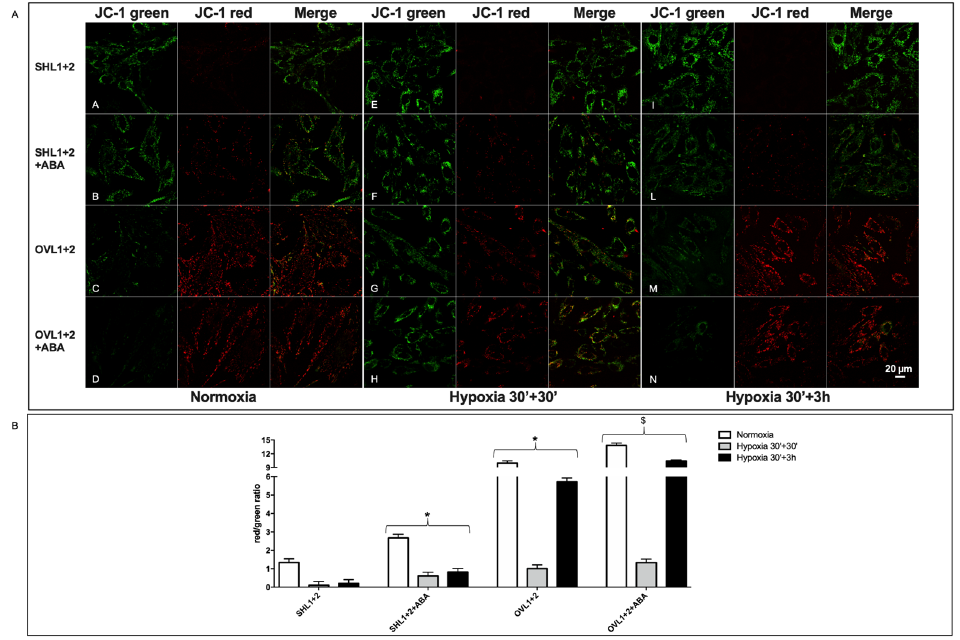
Figure 5. LANCL1/2-overexpressing H9c2 respond to ABA with an increase of the mitochondrial proton gradient after hypoxia/reoxygenation. H9c2 cells overexpressing LANCL1 and LANCL2 (OVL1+2), or double-silenced for the expression of both proteins (SHL1+2), loaded with the ∆Ψ - sensitive fluorescent dye JC-1, were cultured without or with 100 nM ABA under normoxia or subjected to 30 min of nitrogen flux followed by 30 min or 3 h reoxygenation at 37 ◦ C. ( A ) Repre- sentative confocal microscopy images of the cells exposed to the three different culture conditions, normoxia, hypoxia/reoxygenation (30 min + 30 min) and (30 min + 3 h). Rows A and B, double- silenced cells under normoxia, without (A) or with ABA (B); rows E and F, double-silenced cells after hypoxia/reoxygenation (30 min + 30 min), without (E) or with ABA (F); rows I and L, double- silenced cells after hypoxia/reoxygenation (30 min + 3 h), without (I) or with ABA (L). Rows C and D, LANCL1/2-overexpressing cells under normoxia, without (C) or with ABA (D); rows G and H, LANCL1/2-overexpressing cells after hypoxia/reoxygenation (30 min + 30 min), without (G) or